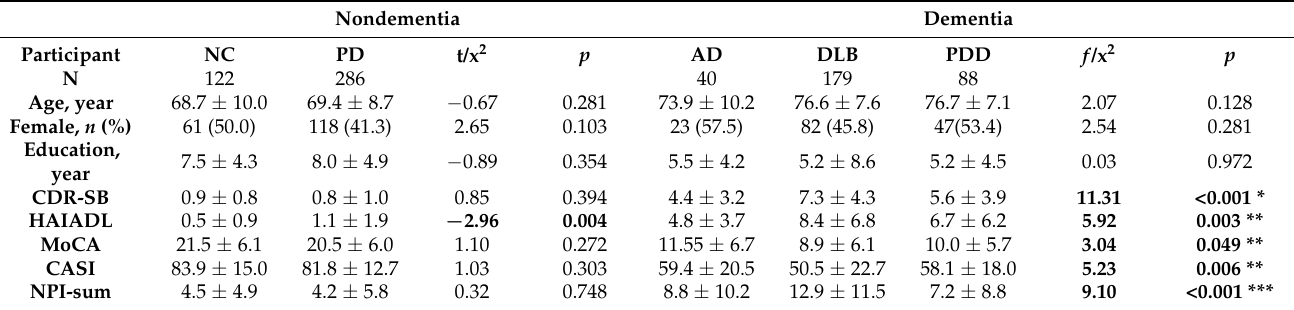
Table 2. Comparison of demographic data between nondementia groups and among demen- tia